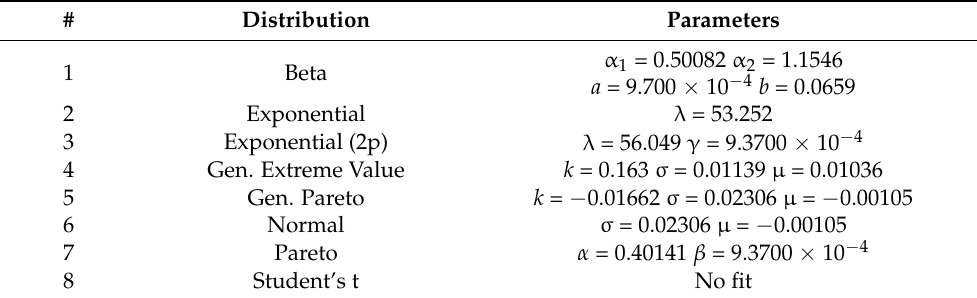
Table 2. Parameter estimation